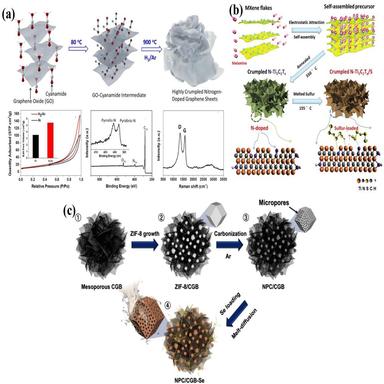
(a) Schematic illustration of the synthesis of highly crumpled NG sheets, N2 adsorption/desorption isotherm and Barrett-Joyner-Halenda pore volume (inset) of the highly crumpled NG sheets with different flow gas during thermal treatment process, the XPS survey and N1s detailed spectra (inset) and Raman spectrum of the crumpled NG sheets Copyright 2016, American Chemical Society; (b) Illustration of synthesis of the crumpled N-Ti3C2Tx/S composites Copyright 2018, Wiley-VCH; (c)